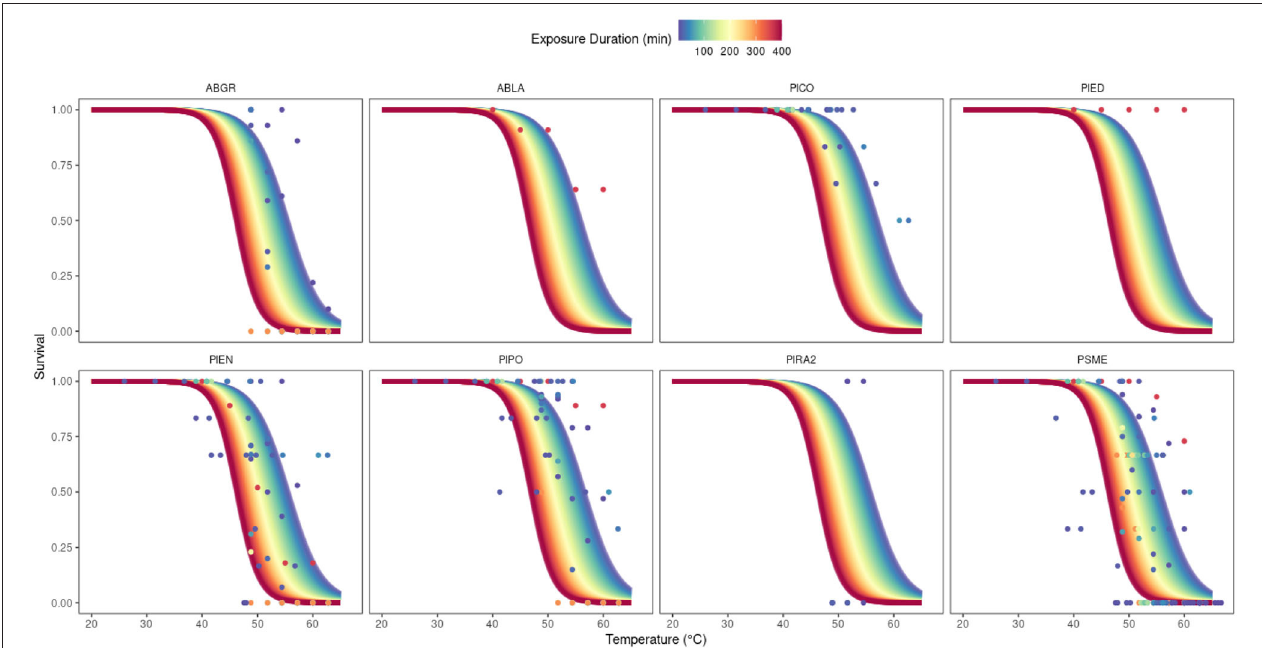
FIGURE 3 | Modelled and observed survival of all conifer species ( Abies grandis (ABGR), Abies lasiocarpa (ABLA), Pinus contorta (PICO), Pinus edulis (PIED), Picea engelmannii (PIEN), Pinus ponderosa (PIPO), Pinus radiata (PIRA2), and Pseudotsuga menziesii (PSME) with respect to surface temperature, colored by experimental duration. Model curves represent the estimated survival probability using mean parameter values from posterior distributions, with β 4 fixed at the value corresponding to the Seidel (1986) study, which accounts for the greatest percentage of observations (49%).